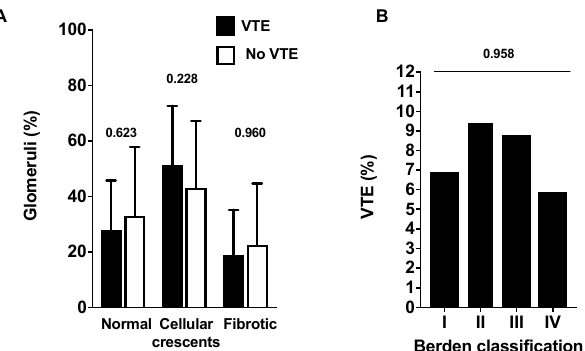
Figure 3. Kidney biopsy histology according to early venous thromboembolism (VTE) occurrence. ( A ) percentage of normal, crescentic, or sclerotic glomeruli in patients with and without early VTE. ( B ) percentage of patients with VTE according to Berden’s classification. I, focal; II, crescentic; III, mixed; and IV, sclerotic form.